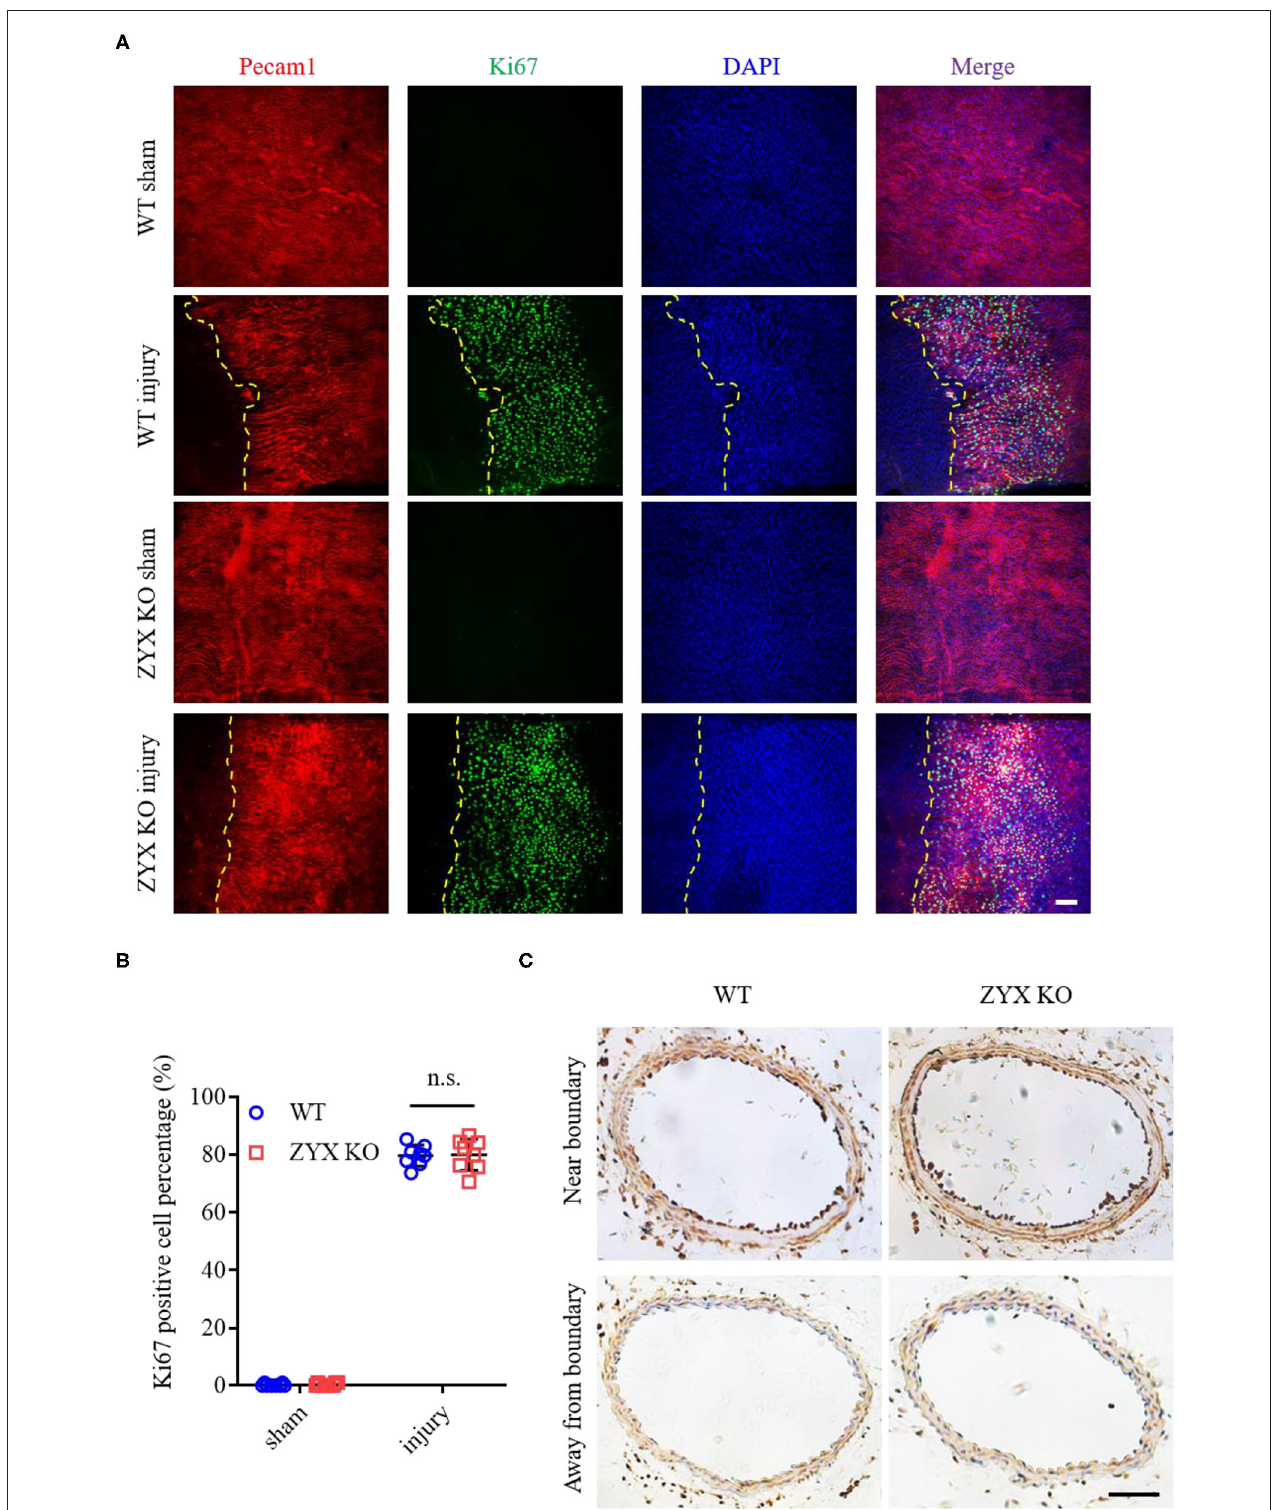
FIGURE 2 | Proliferation is not involved in the re-endothelialization of injured arteries in zyxin-deficient mice. (A) Representative immunofluorescence staining of Pecam1, Ki67, and 4’, 6-diamidino-2 phenylindole dihydrochloride (DAPI) in carotid arteries 3 days after injury (scale bar, 25 µ m). (B) Quantification of the Ki67 positive cell percentage. (C) Representative IHC staining of Ki67 in carotid artery cross-sections that are near (upper) or away (below) from the injured boundary 3 days after injury (scale bar, 100 µ m). Mean ± SD, n = 8; n.s., not significantly different. Test of Normality: P > 0.05, test of homogeneity: P > 0.05. WT, wild type; ZYX KO, zyxin